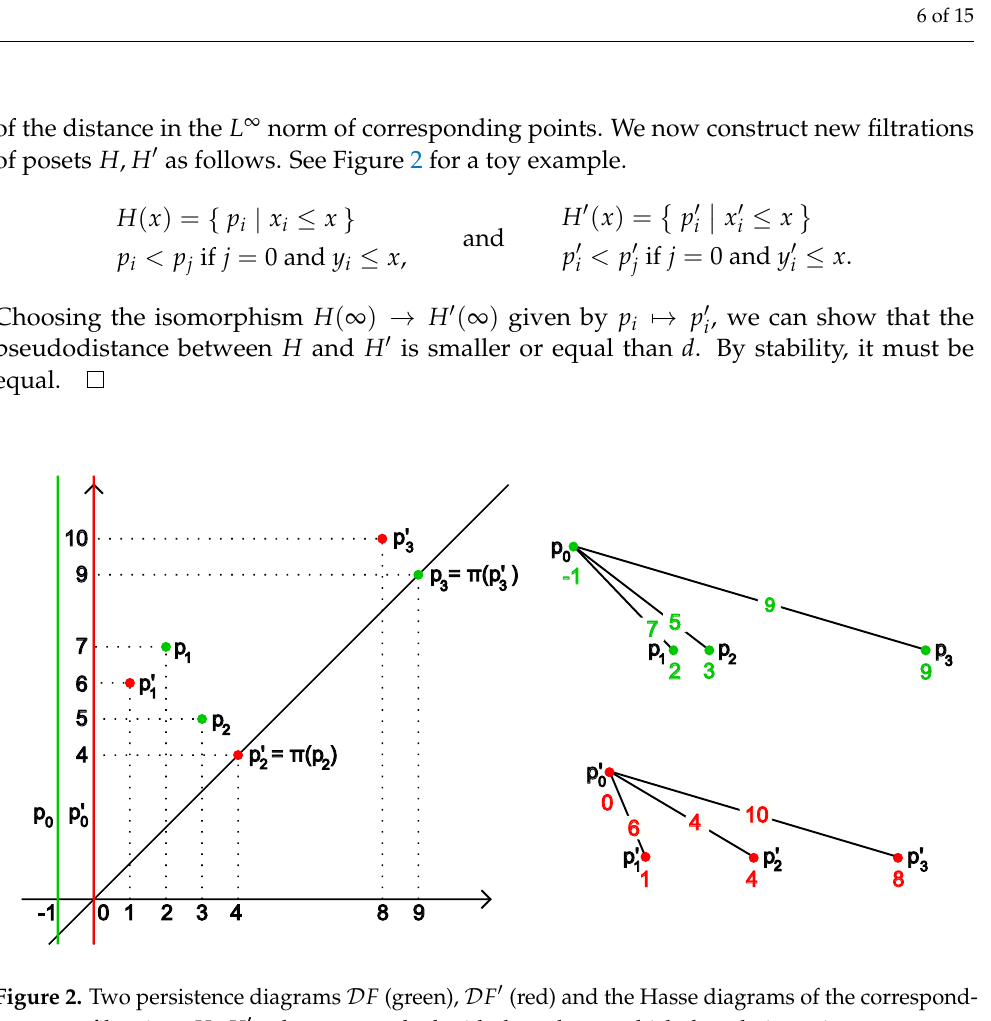
Figure 2. Two persistence diagrams D F (green), D F (cid:48) (red) and the Hasse diagrams of the correspond- ing poset filtrations H , H (cid:48) ; edges are marked with the value at which the relation